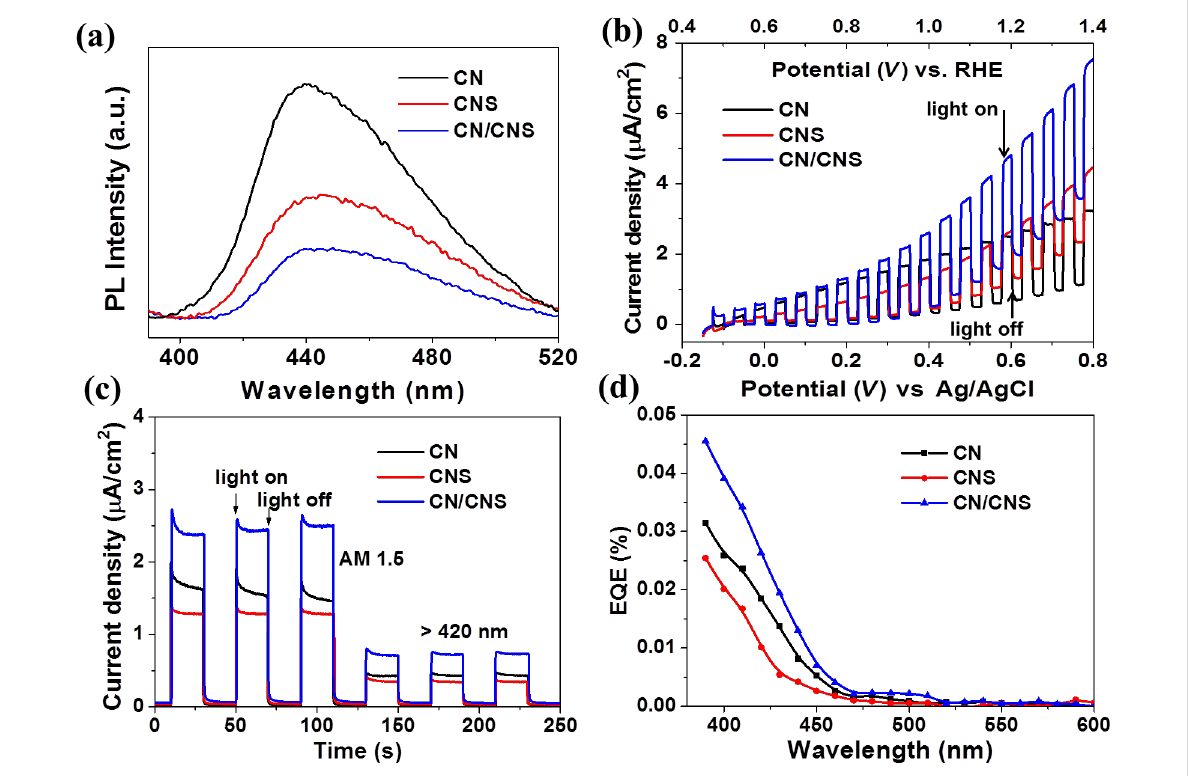
Figure 6: (a) Photoluminescence of CN, CNS and CN/CNS in aqueous solution. (b) Current density–voltage ( J – V ) curves for CN, CNS and CN/CNS electrodes under simulated sunlight (AM 1.5, 100 mW/cm 2 ). All experiments were performed in 0.2 M Na 2 SO 4 aqueous solution at a scan rate of 10 mV/s. (c) Current density–time ( J – t ) curves for CN, CNS and CN/CNS electrodes with 0.4 V bias vs Ag/AgCl under simulated sunlight (AM 1.5, 100 mW/cm 2 ) and visible light ( λ > 420 nm). (d) External quantum efficiency (EQE) of CN, CNS and CN/CNS